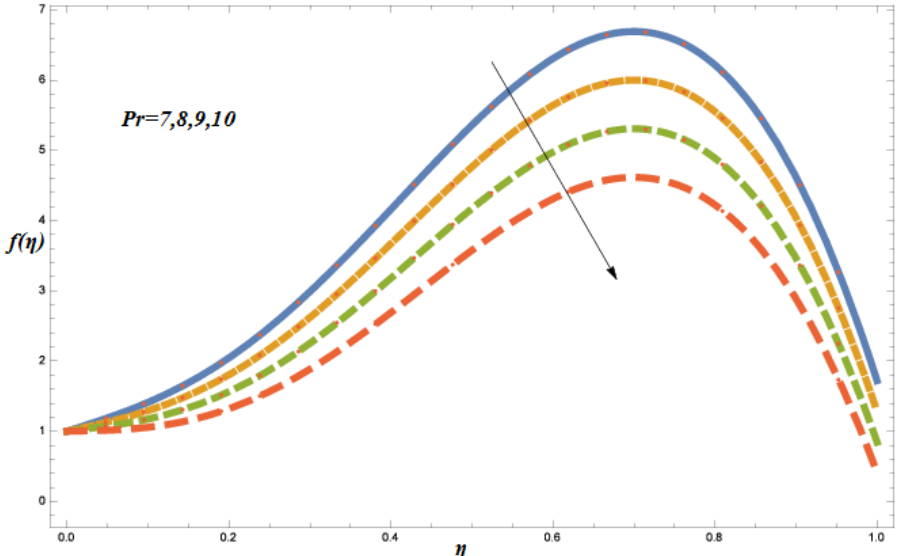
Figure 10. Variation in velocity field f ( η ) for various values of P r , when (cid:125) = − 0.25, D u = 0.7, S c = 0.7, λ = 0.7, Λ = 0.7, β = 1, S = 0.7.